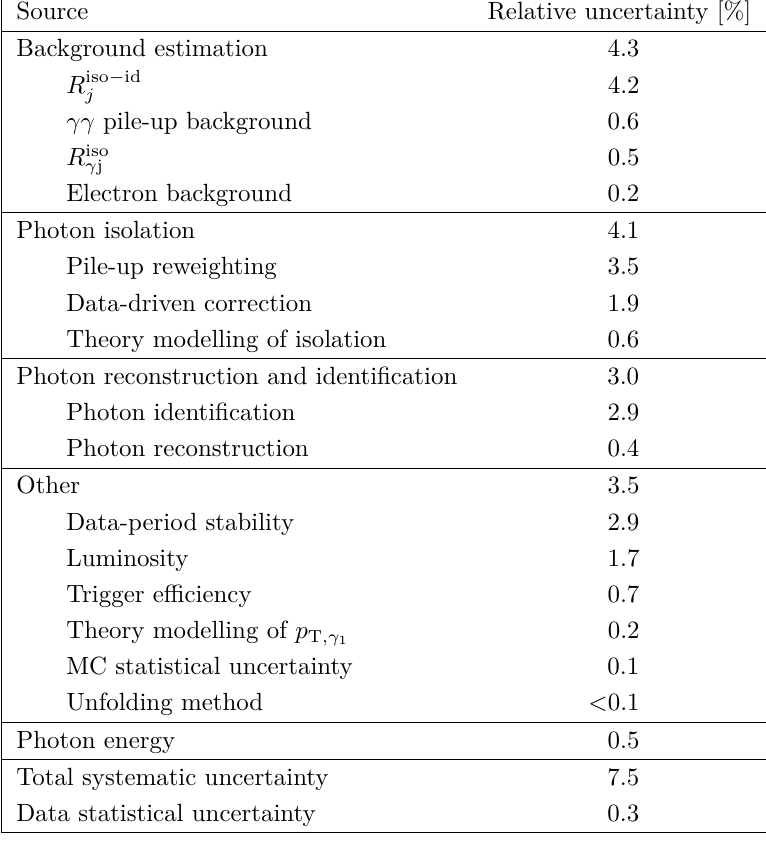
Table 3. Breakdown of the relative uncertainties in the integrated fiducial cross-section measure- ment. The uncertainties are grouped into different categories and the first row of each category shows the sum in quadrature of its